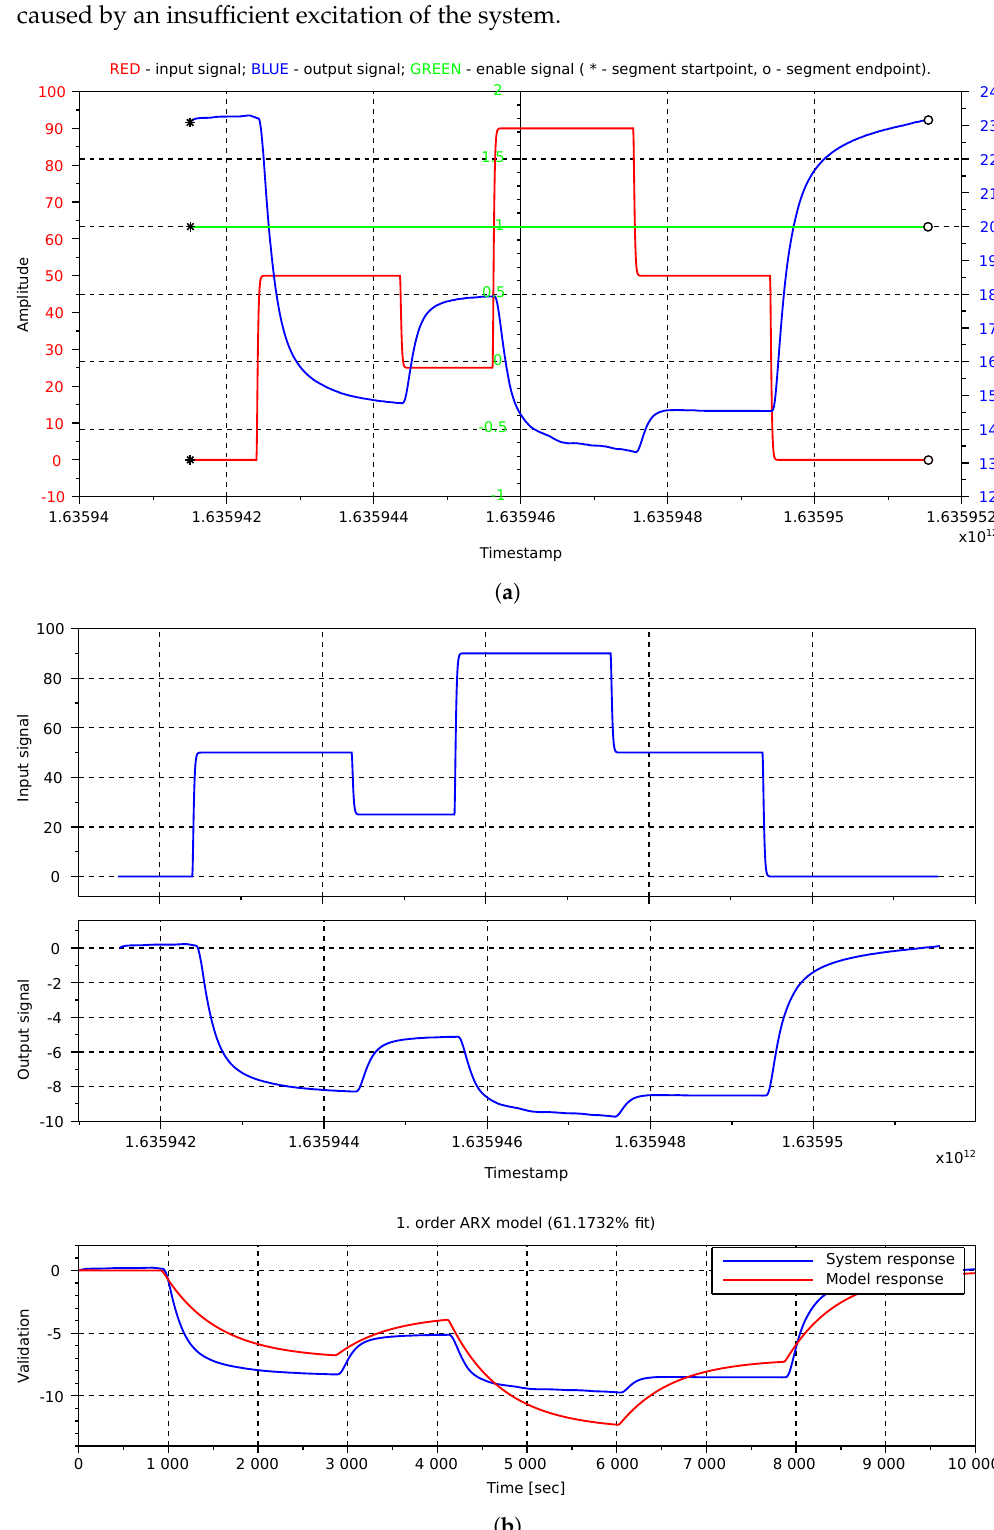
Figure 6. Graphical output from identification of the cooling process in room-1 . ( a ) Input, output and enable/disable signals, and their segmentation. ( b ) Input and output data used for identification and model